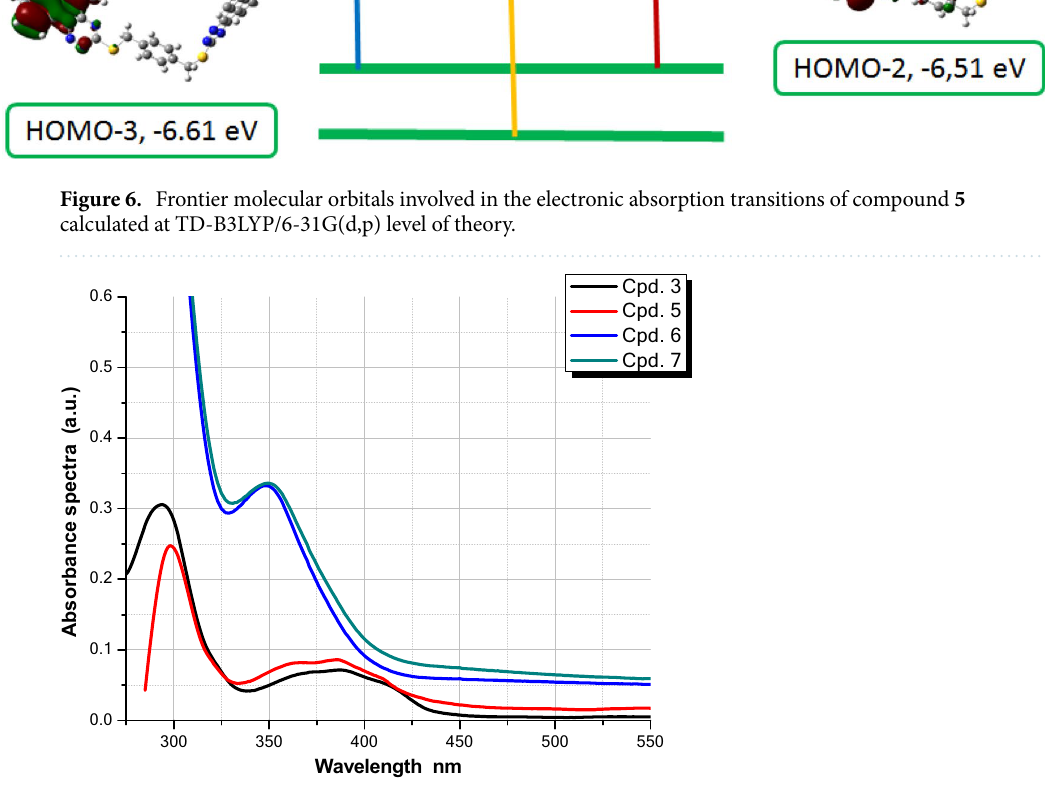
Figure 7. Absorption spectra of 2 × 10 –5 M of different triazine chromophores in